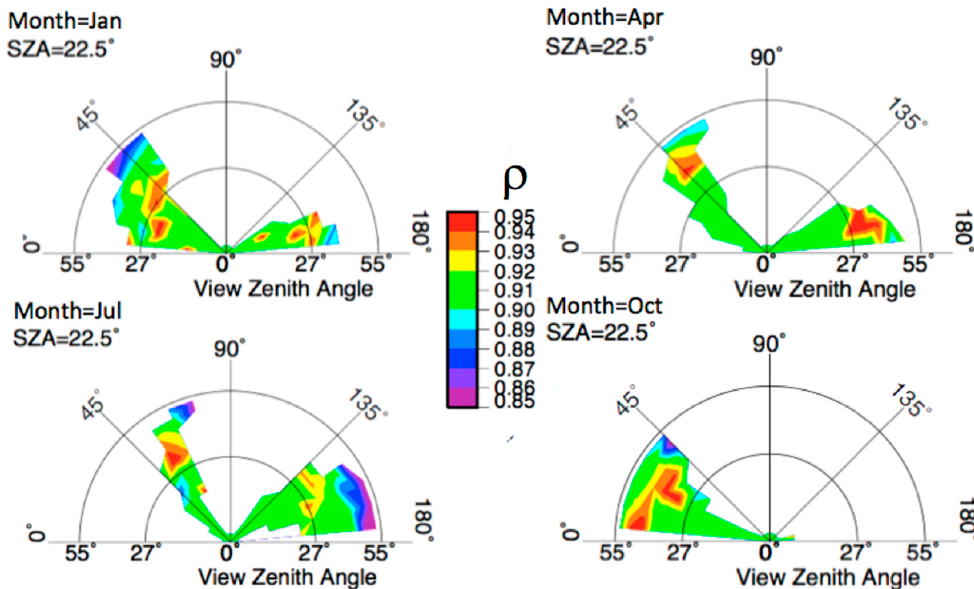
Figure 6. The January, April, July and October DCC reflectances of the VIIRS M5 (0.65 µm) VIS band reflectances for the 5° SZA bin centered at 22.5°. The VZAs (range 0° to 55°) are shown along the radial coordinate with a 5° bin size, and RAAs are shown on the angular coordinate with a 10° bin size. Forward scattering is found at RAA = 0.